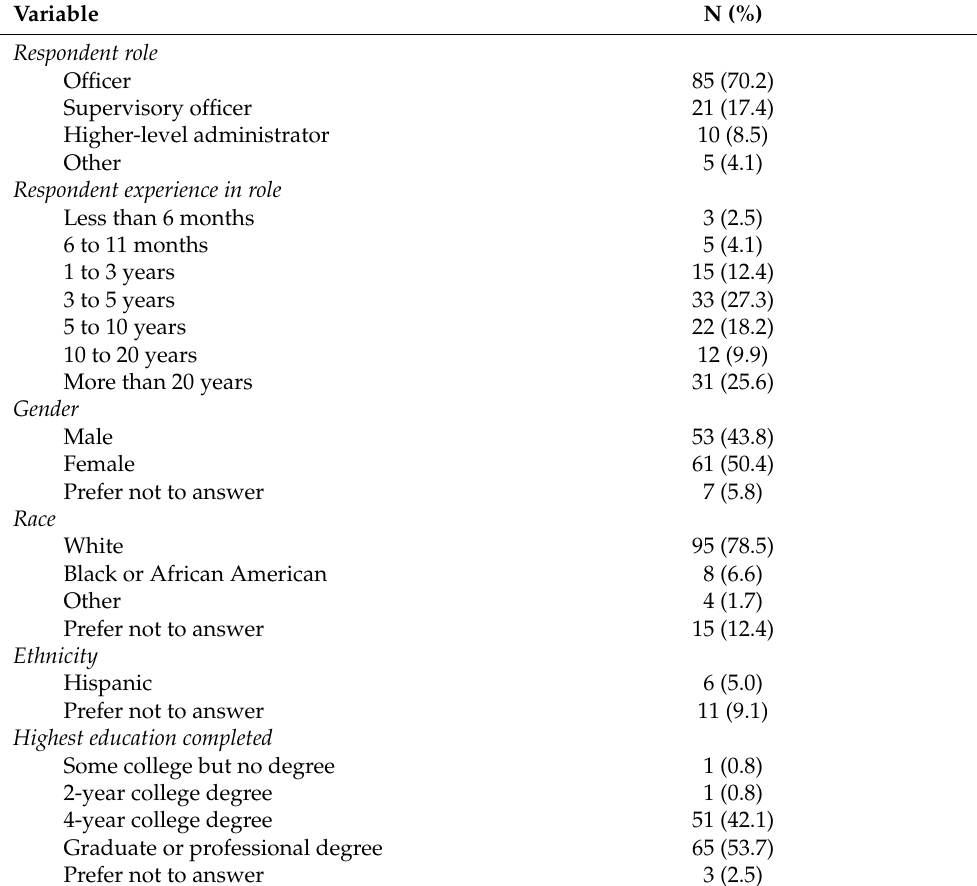
Table 1. Study Sample (N =